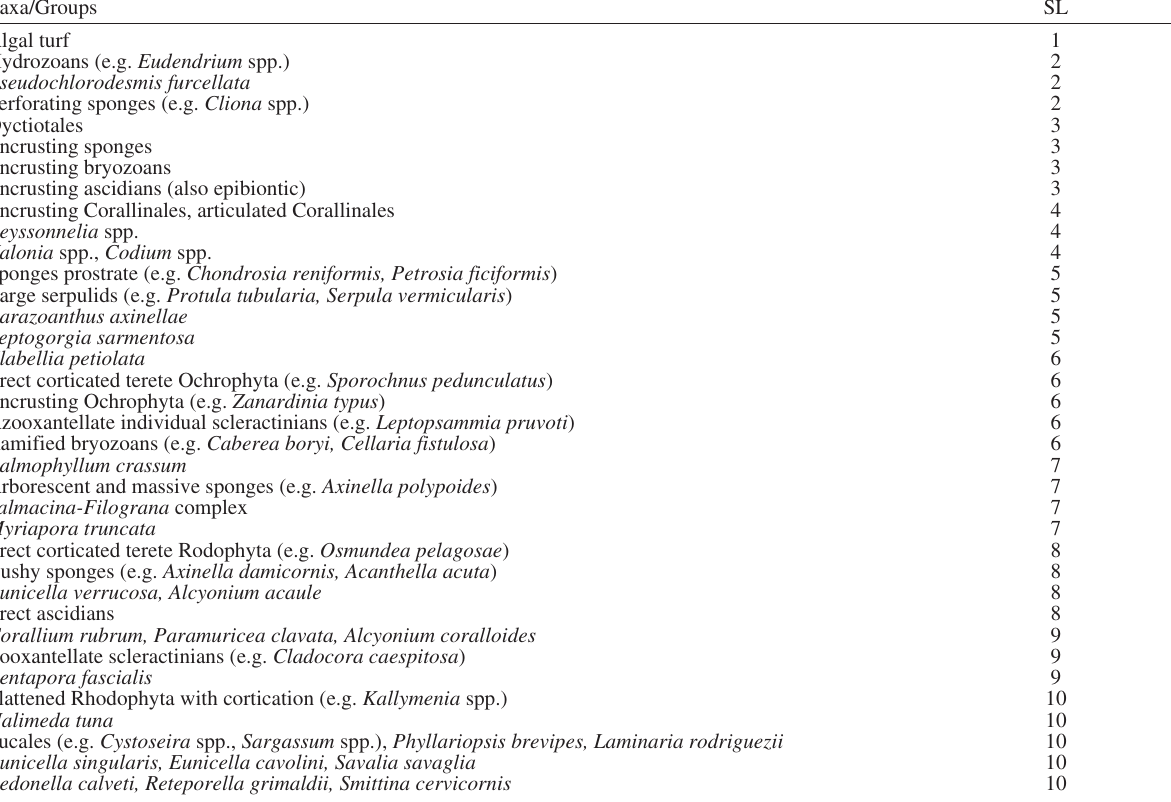
Table 3. – Sensitivity Level (SL) of the main taxa/morphological groups in the coralligenous assemblages. Taxa/Groups